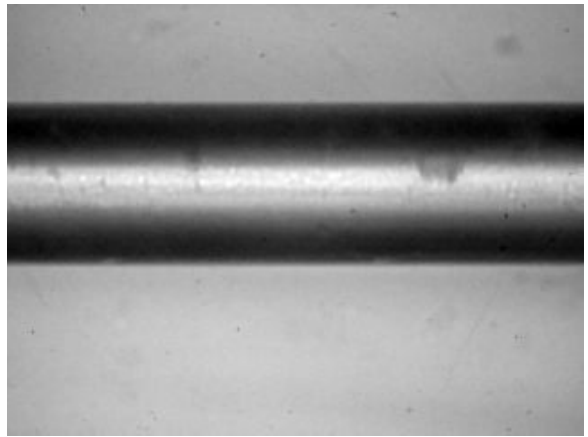
Figure 1. The PVDF monofilament fiber, magn. × 10.